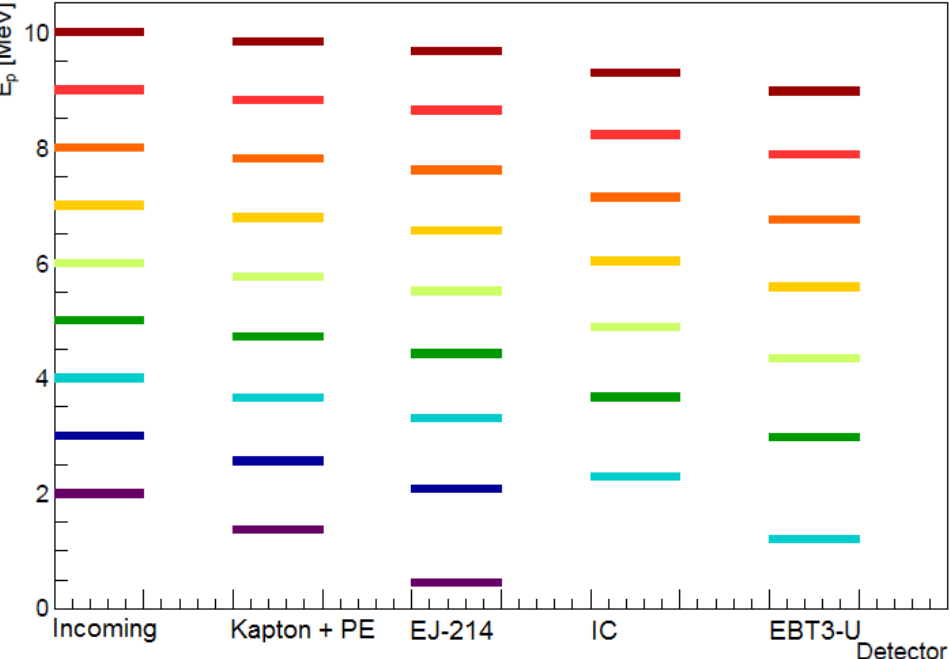
Figure 4. Particle energies after passage through fluence detectors. Colours correspond to the selected lines of the incoming beam in